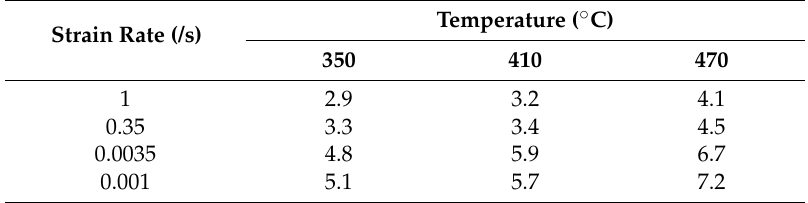
Table 3. Mean grain size ( µ m) after deformation under different test conditions.